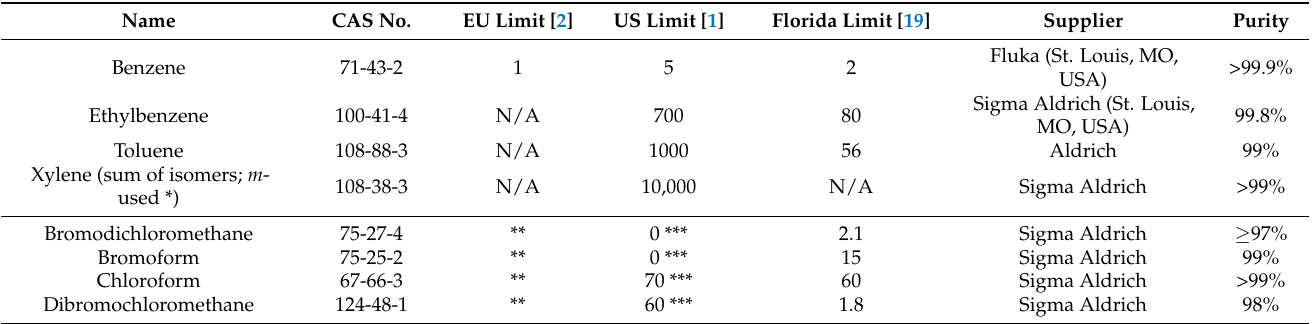
Table 1. Target compounds in this study, limits in drinking water for the EU [2] and maximum contaminant level (MCL) for the United States [1] and the State of Florida [19], supplier, and purity. Limits are µ g L − 1 in